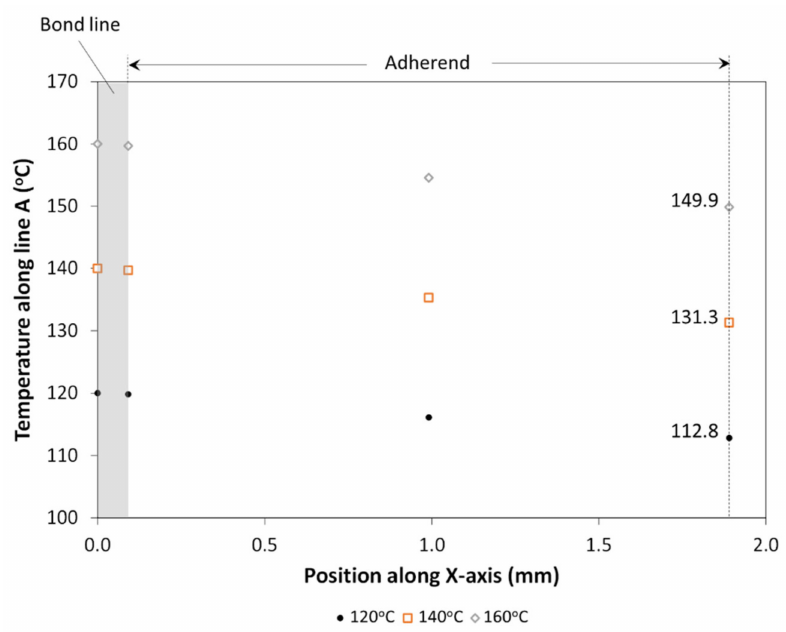
Figure 5. Predicted through-the-thickness temperature profiles along line A at the cross-section labeled in Figure 4b when interface is set at a temperature of 120 ◦ C, 140 ◦ C and 160 ◦ C. The bond line material was 15 wt.%